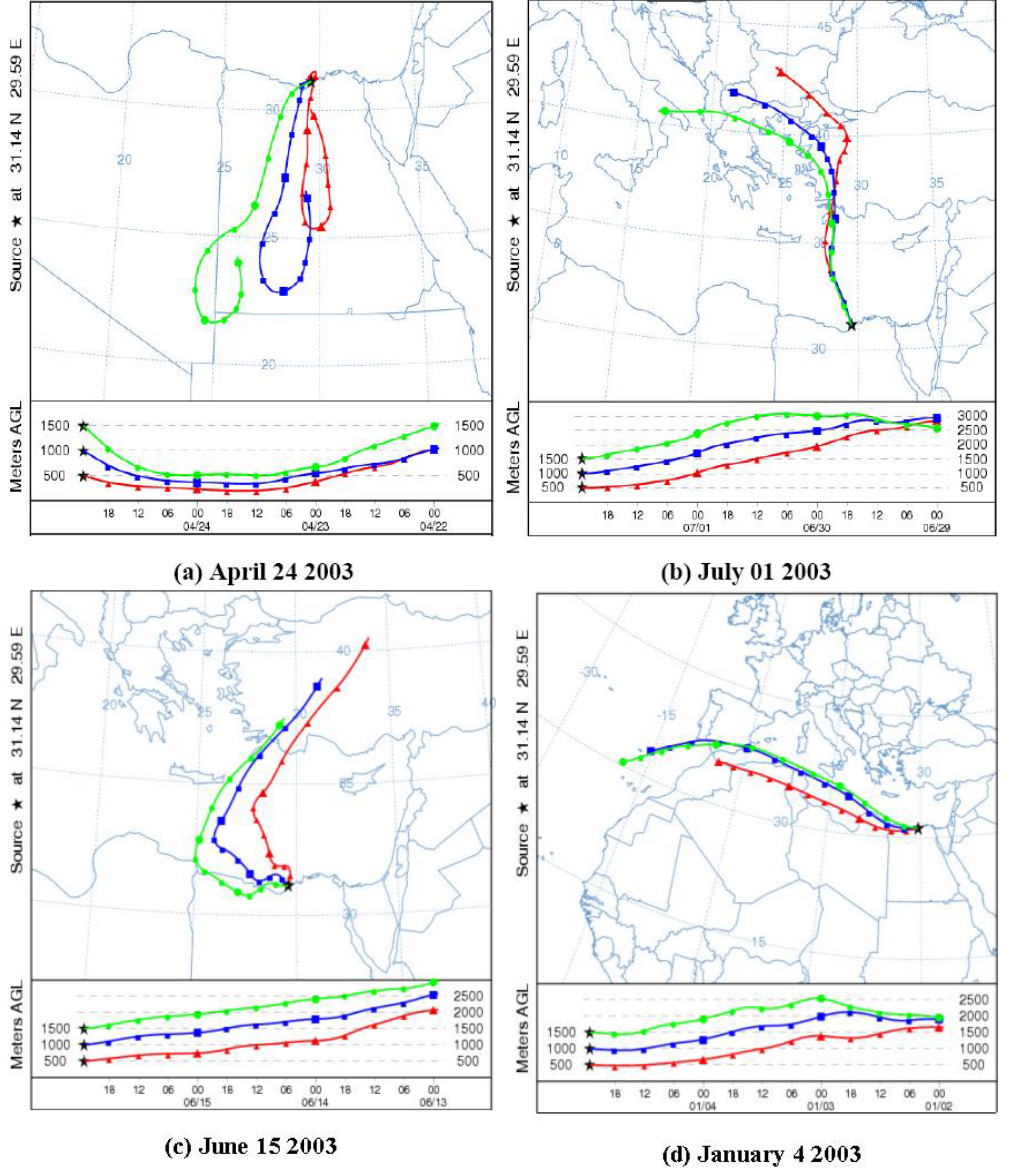
Fig. 4. HYSPLIT back-trajectory analysis at different vertical levels (red: 500m, blue: 1000m, green: 1500m) ending over Alexandria showing (a) dusty, (b) pollution, (c) mixed, (d) clean conditions in